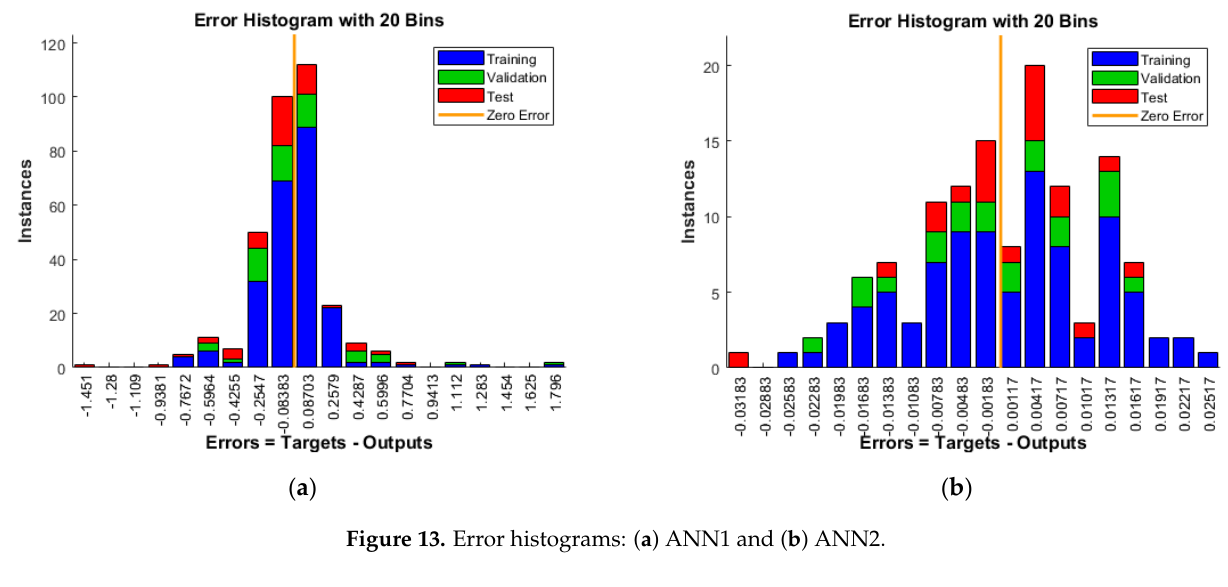
Figure 13. Error histograms: ( a ) ANN1 and ( b ) ANN2.